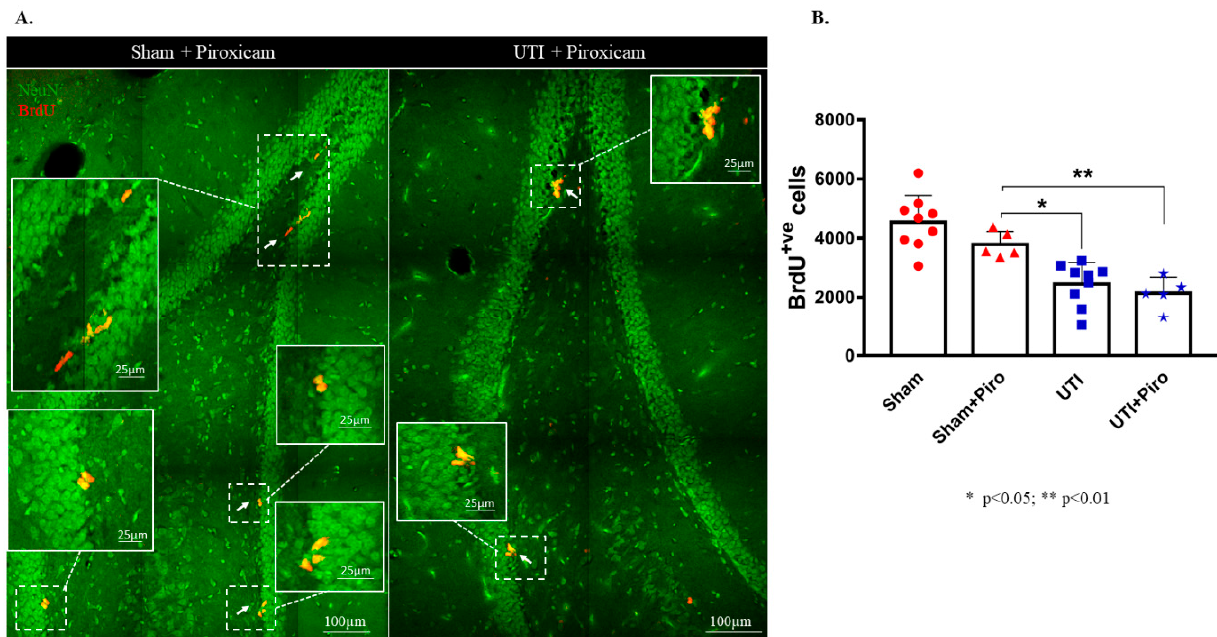
Figure 8. Treatment with Piroxicam (Piro) does not revert the decrease in NSCs on day 4 post infection. ( A ) Representative confocal images of the DG of Piroxicam-treated-vehicle ( n = 5) and UTI rats ( n = 5) showing NeuN (green) and BrdU-positive cells (red; arrows). Images were taken as Z stacks and a tile scan using a 40 × -oil objective. ( B ) Stereological quantification of BrdU-labeled cells in the DG of Piroxicam-treated sham and UTI rats sacrificed on day 4 post infection. Each bar represents the average ± SEM of BrdU-positive cells per group and each dot represents measured number for each rat. Determination of statistical significance of differences was generated using one-way Anova followed by Tukey’s multiple comparison